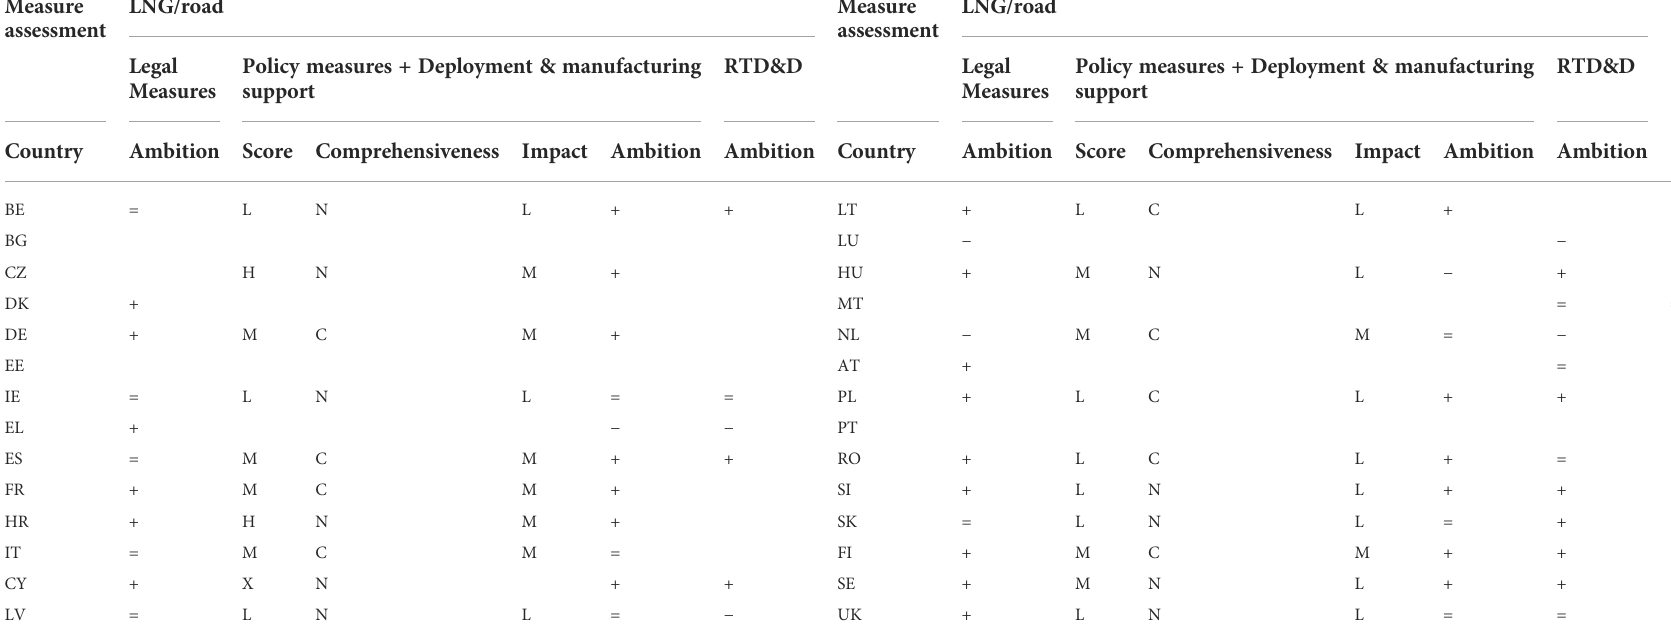
TABLE 1 Results of the measure assessment for